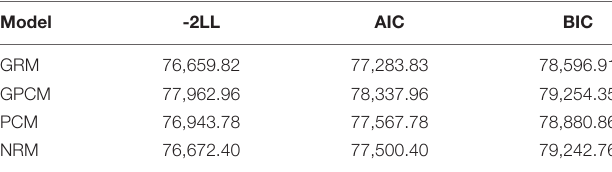
TABLE 2 | Test-level model fit for the four polytomously scored IRT models.